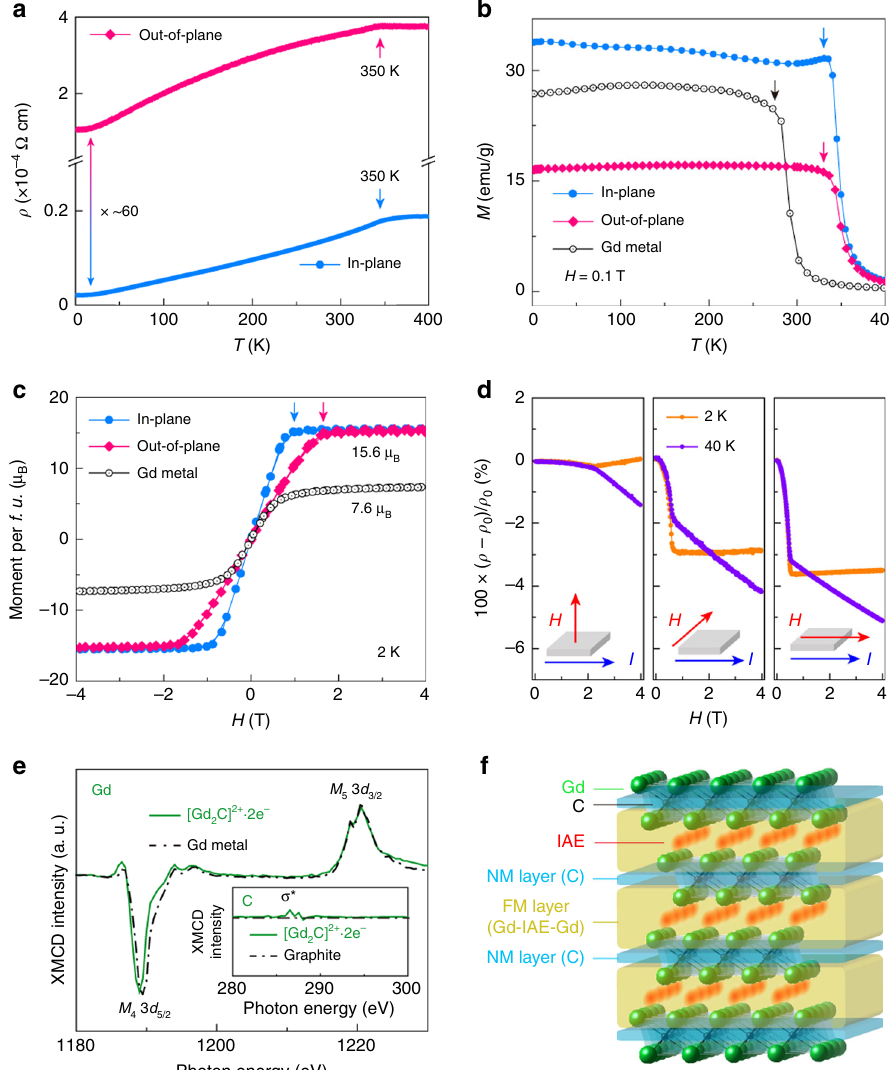
Fig. 2 FM 2D [Gd 2 C] 2 + ·2e − electride. a , b Temperature ( T ) dependences of electrical resistivity ( ρ ) ( a ) and magnetization ( M ) ( b ) for single-crystal [Gd 2 C] 2 + ·2e − electride and Gd metal under a magnetic fi eld of 0.1 T. c Magnetic fi eld ( H ) dependence of M for single-crystal [Gd 2 C] 2 + ·2e − electride and Gd metal at 2 K. Each arrow indicates the saturation fi eld of M . d H dependence of magnetoresistance under different directions of H . e XMCD spectra for Gd and C (inset) of single-crystal [Gd 2 C] 2 + ·2e − electride compared with Gd metal and graphite (dotted curves). f Schematic illustration of the proposed FM/NM layered magnetic